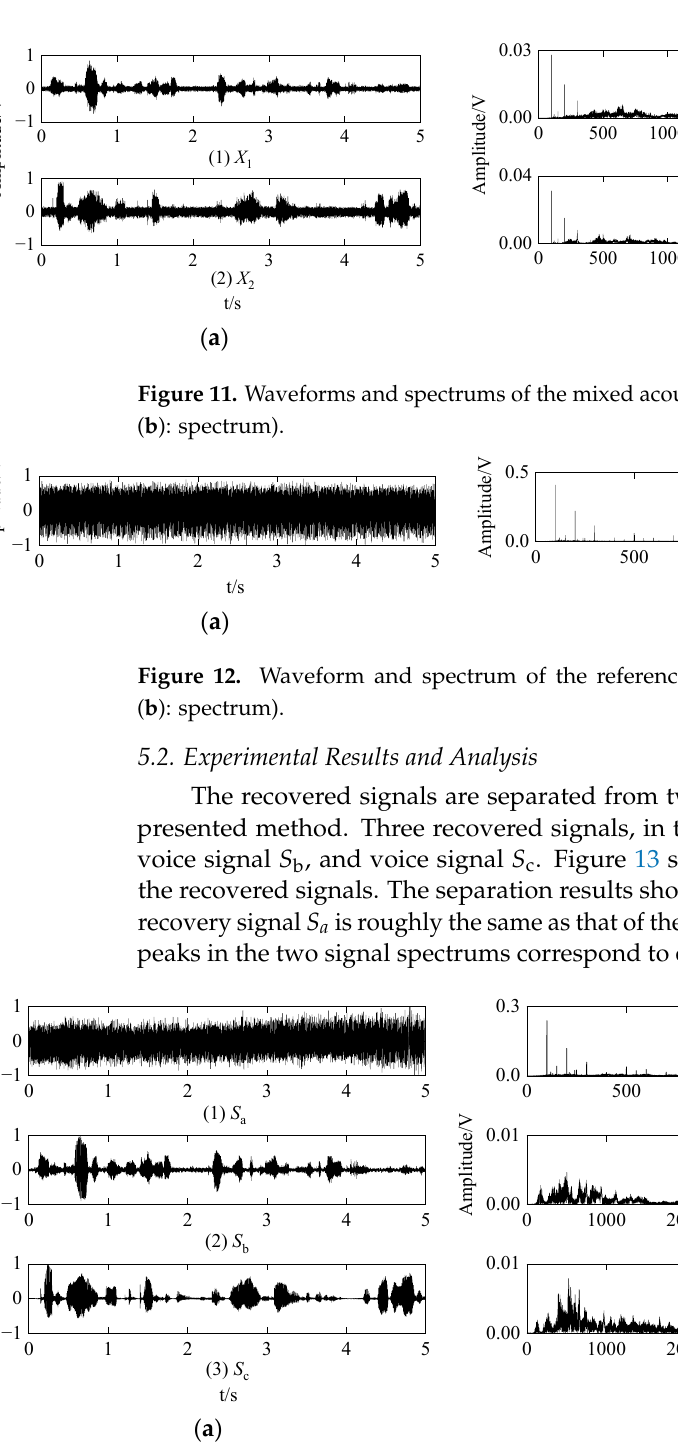
Figure 13. Waveforms and spectrums of the recovered signals in the substation; (( a ): waveform; ( b ): spectrum.).